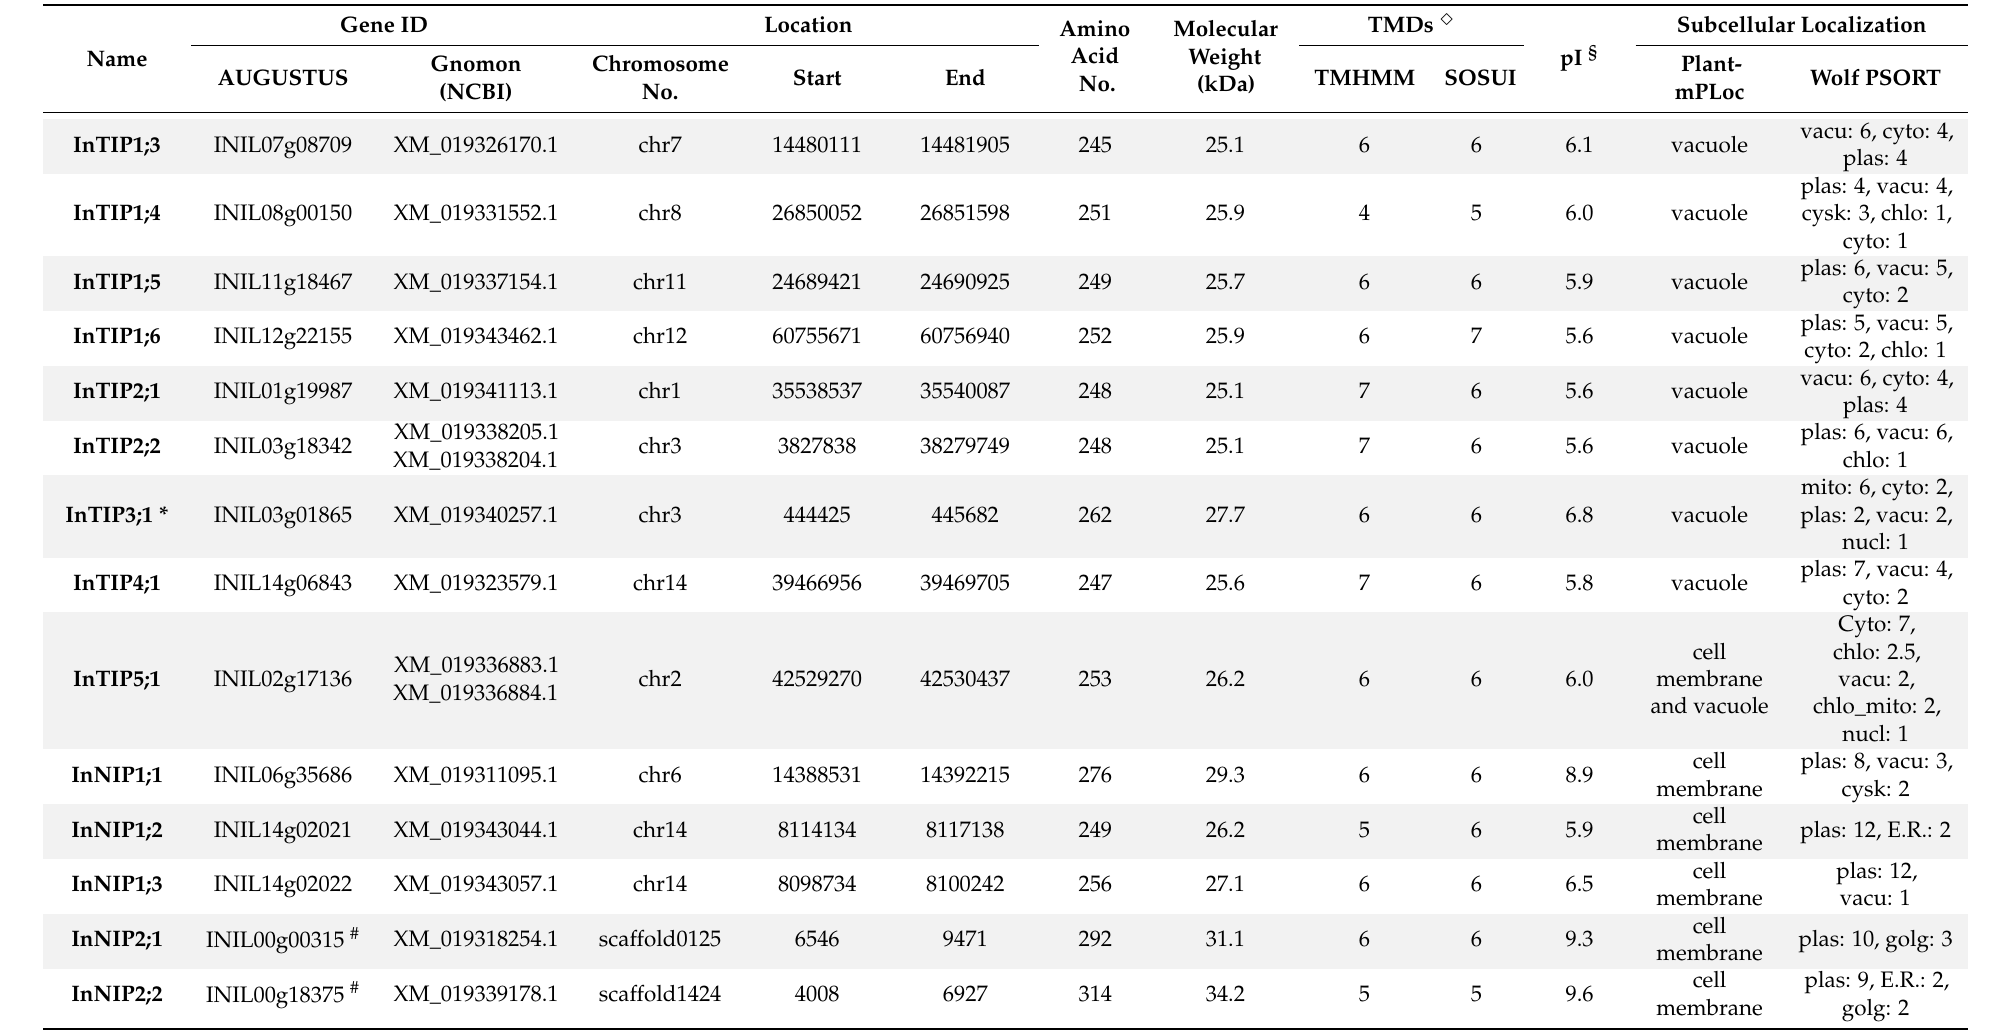
plas: 10, golg: 3 plas: 9, E.R.: 2, golg: